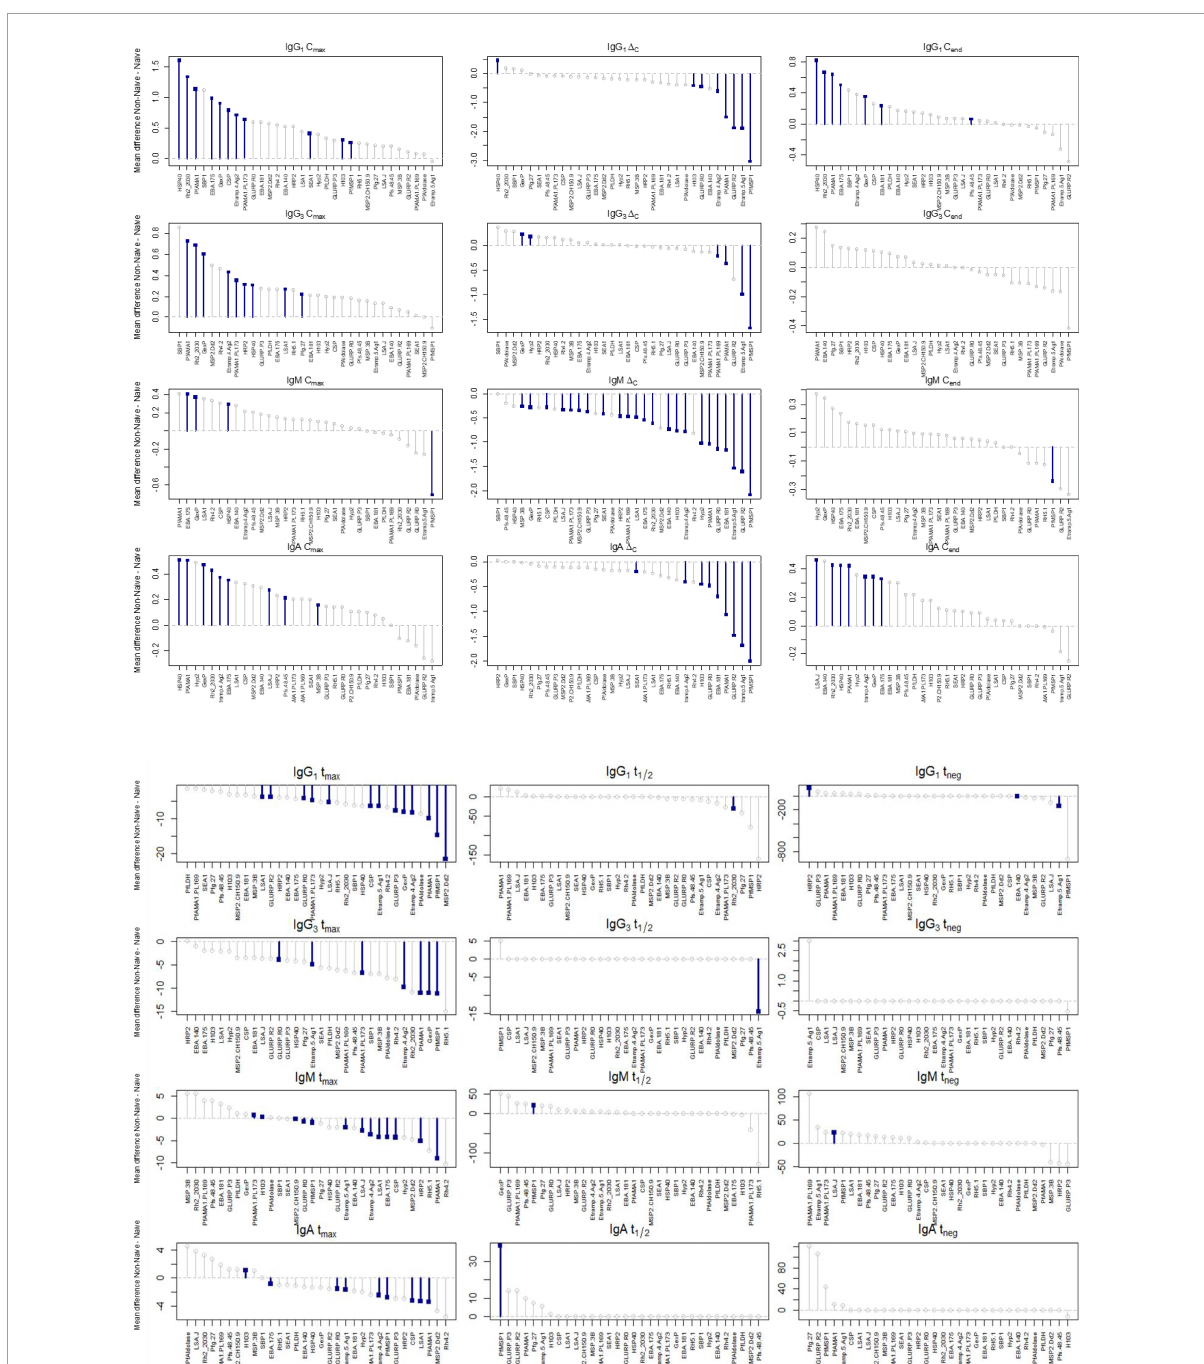
FIGURE4 Mean differences for each parameter by Ig response for non-naïve and naïve children followed post-treatment. Positive values represent higher values in non-naïves, and lines with blue squares denote statistically significant differences.